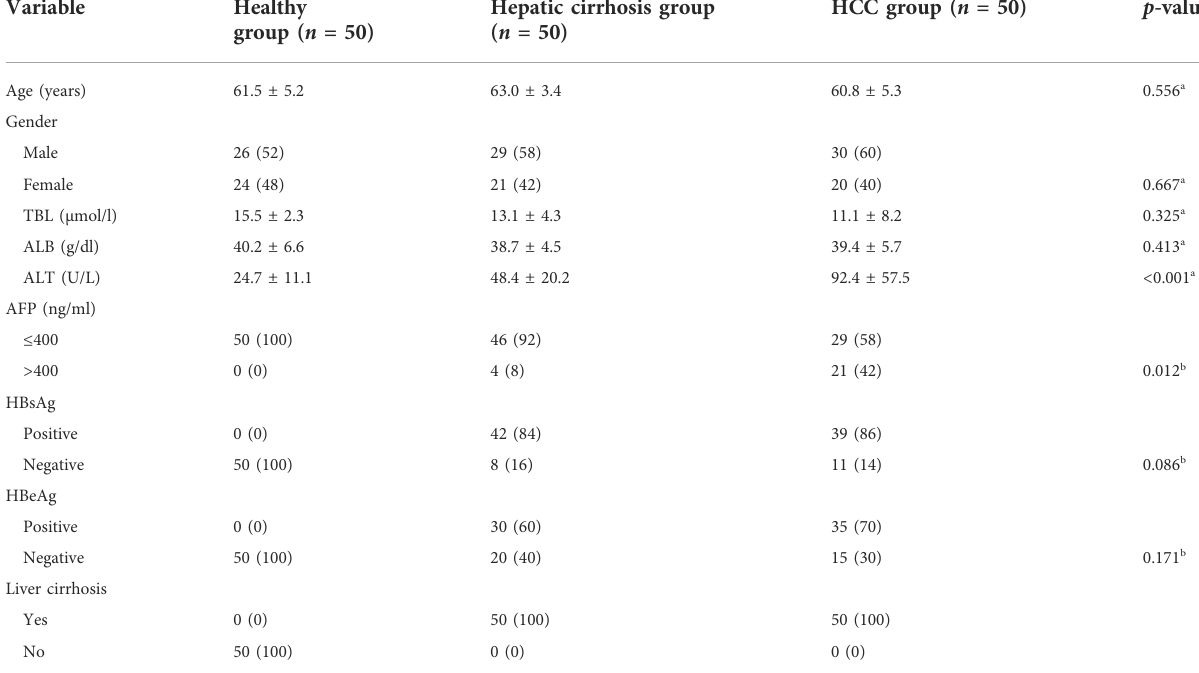
TABLE 1 Characteristics of the participants enrolled in the